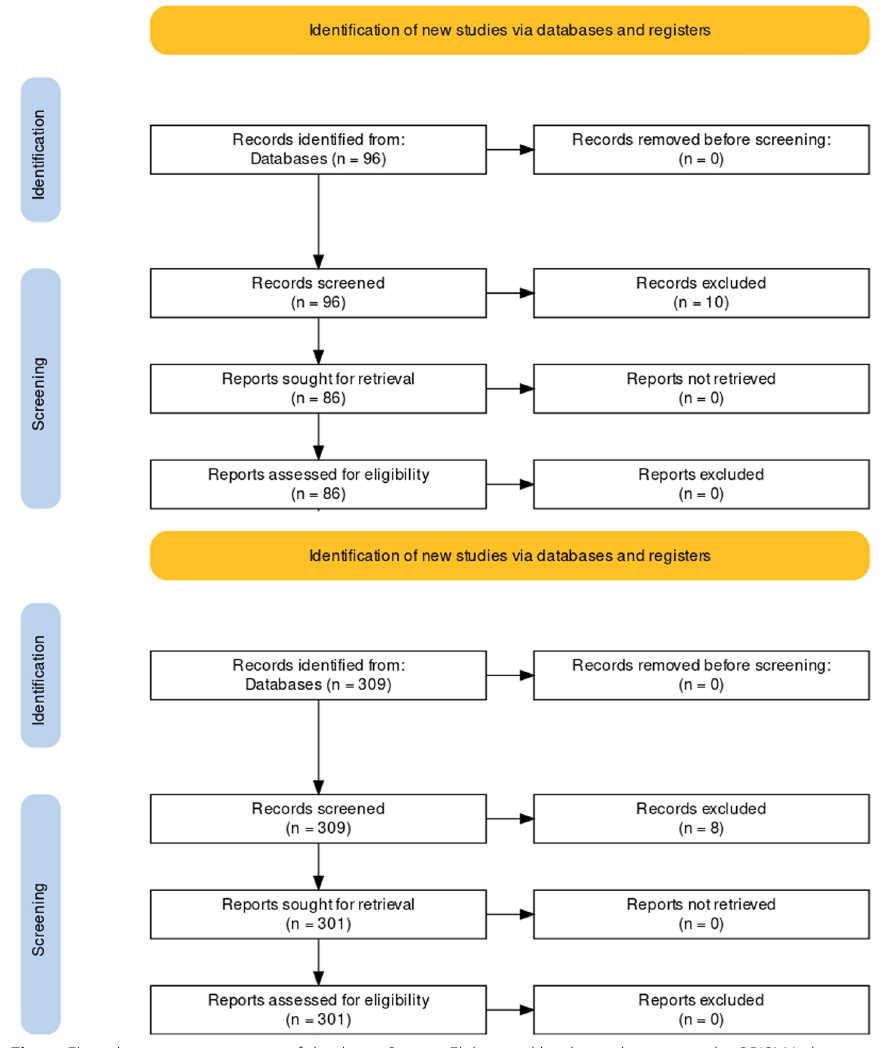
Fig. 1 Flow diagram construction of database. Source: Elaborated by the authors using the PRISMA diagram (Tricco et.al 2018; Page et.al 2020). The first one is the process of REDES Journal, and the one below, it is for the Social Networks